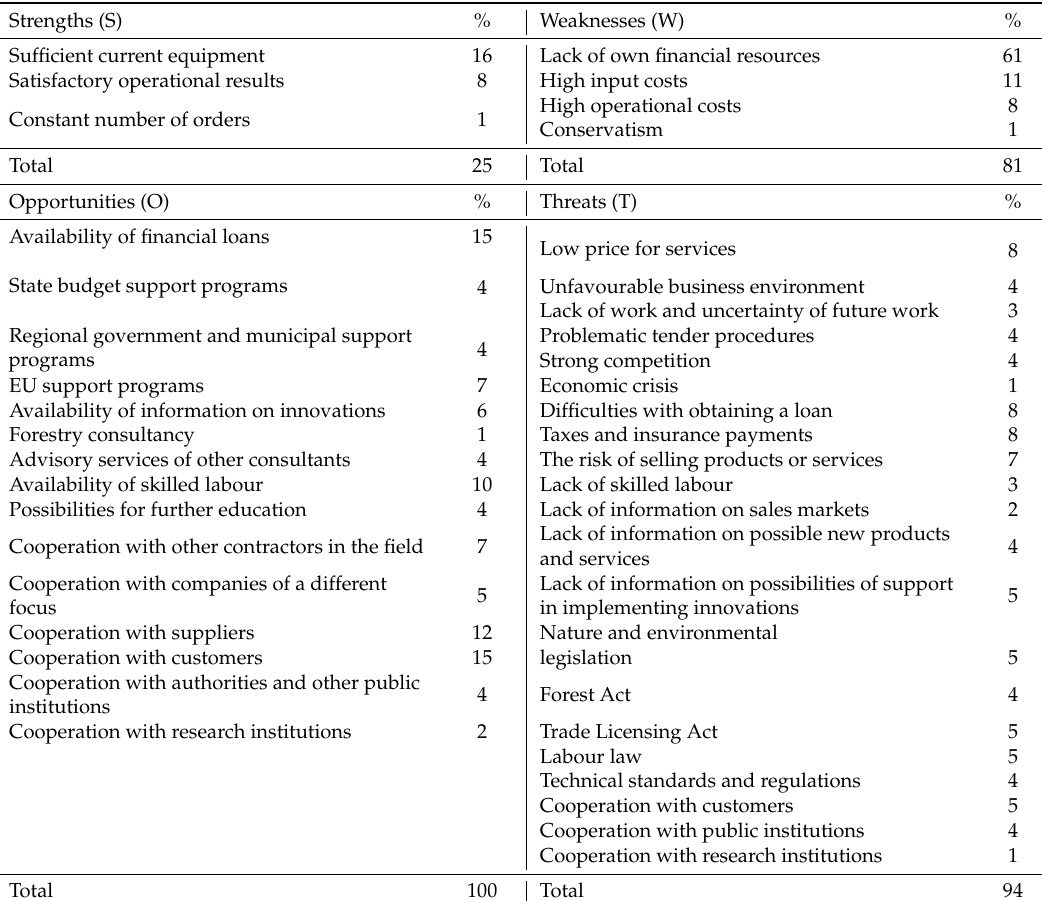
Table 1. SWOT analysis—innovative behaviour of contractor firms providing services in the Slovak forestry